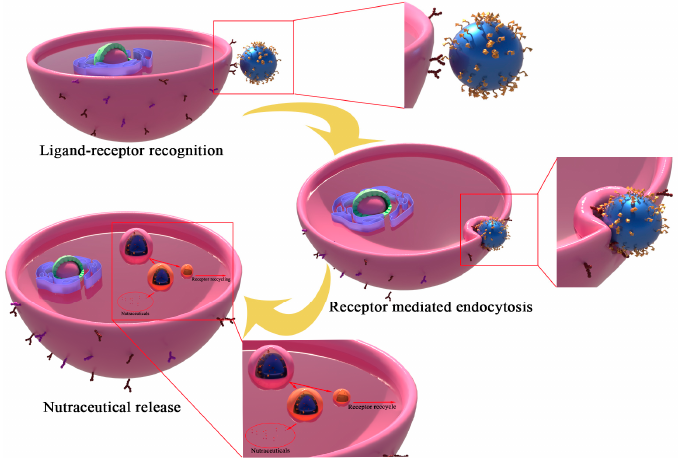
Figure 3. Receptor-mediated endocytosis and the cell-targeted delivery of nutraceuticals.